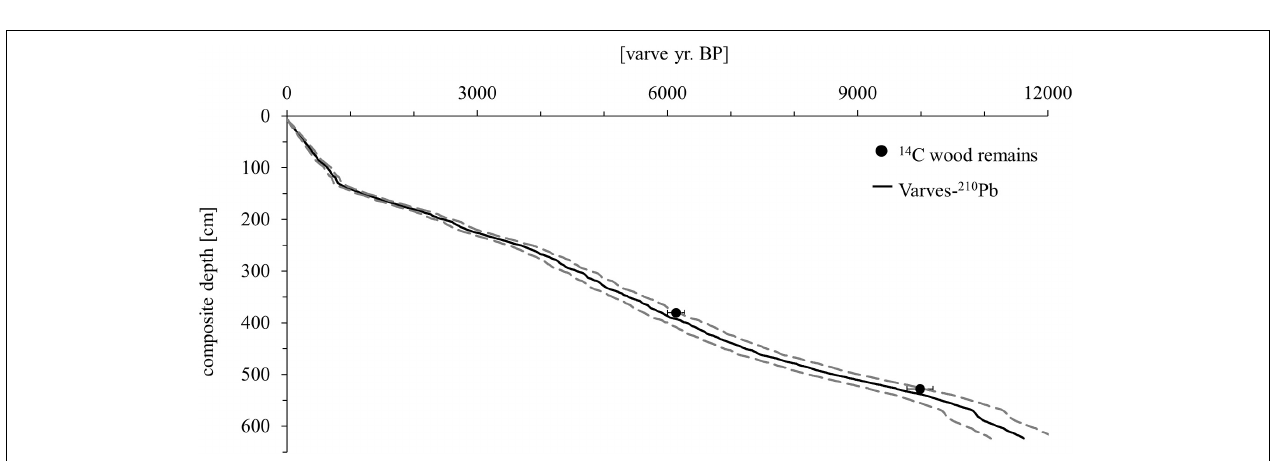
FIGURE 2 | Age model of the Lake Chatyr Kol sediment record. Black dots represent 14 C ages of terrestrial macro remains with two σ error ranges. The age model (solid black line) is based on varve counting combined with 210 Pb measurements. Dashed lines represent the uncertainty of the varve chronology (Kalanke et al.,